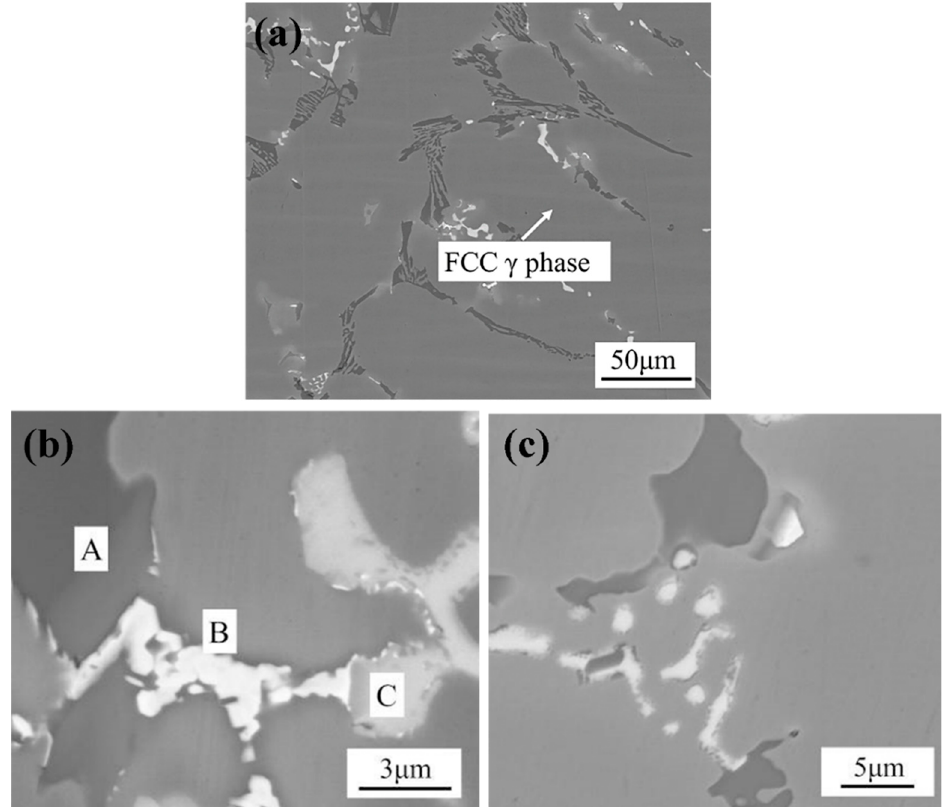
Figure 2. Typical microstructure of ( a ) matrix; carbide skeleton ( b ) carbide precipitation phase and ( c ) punctate M 6 C